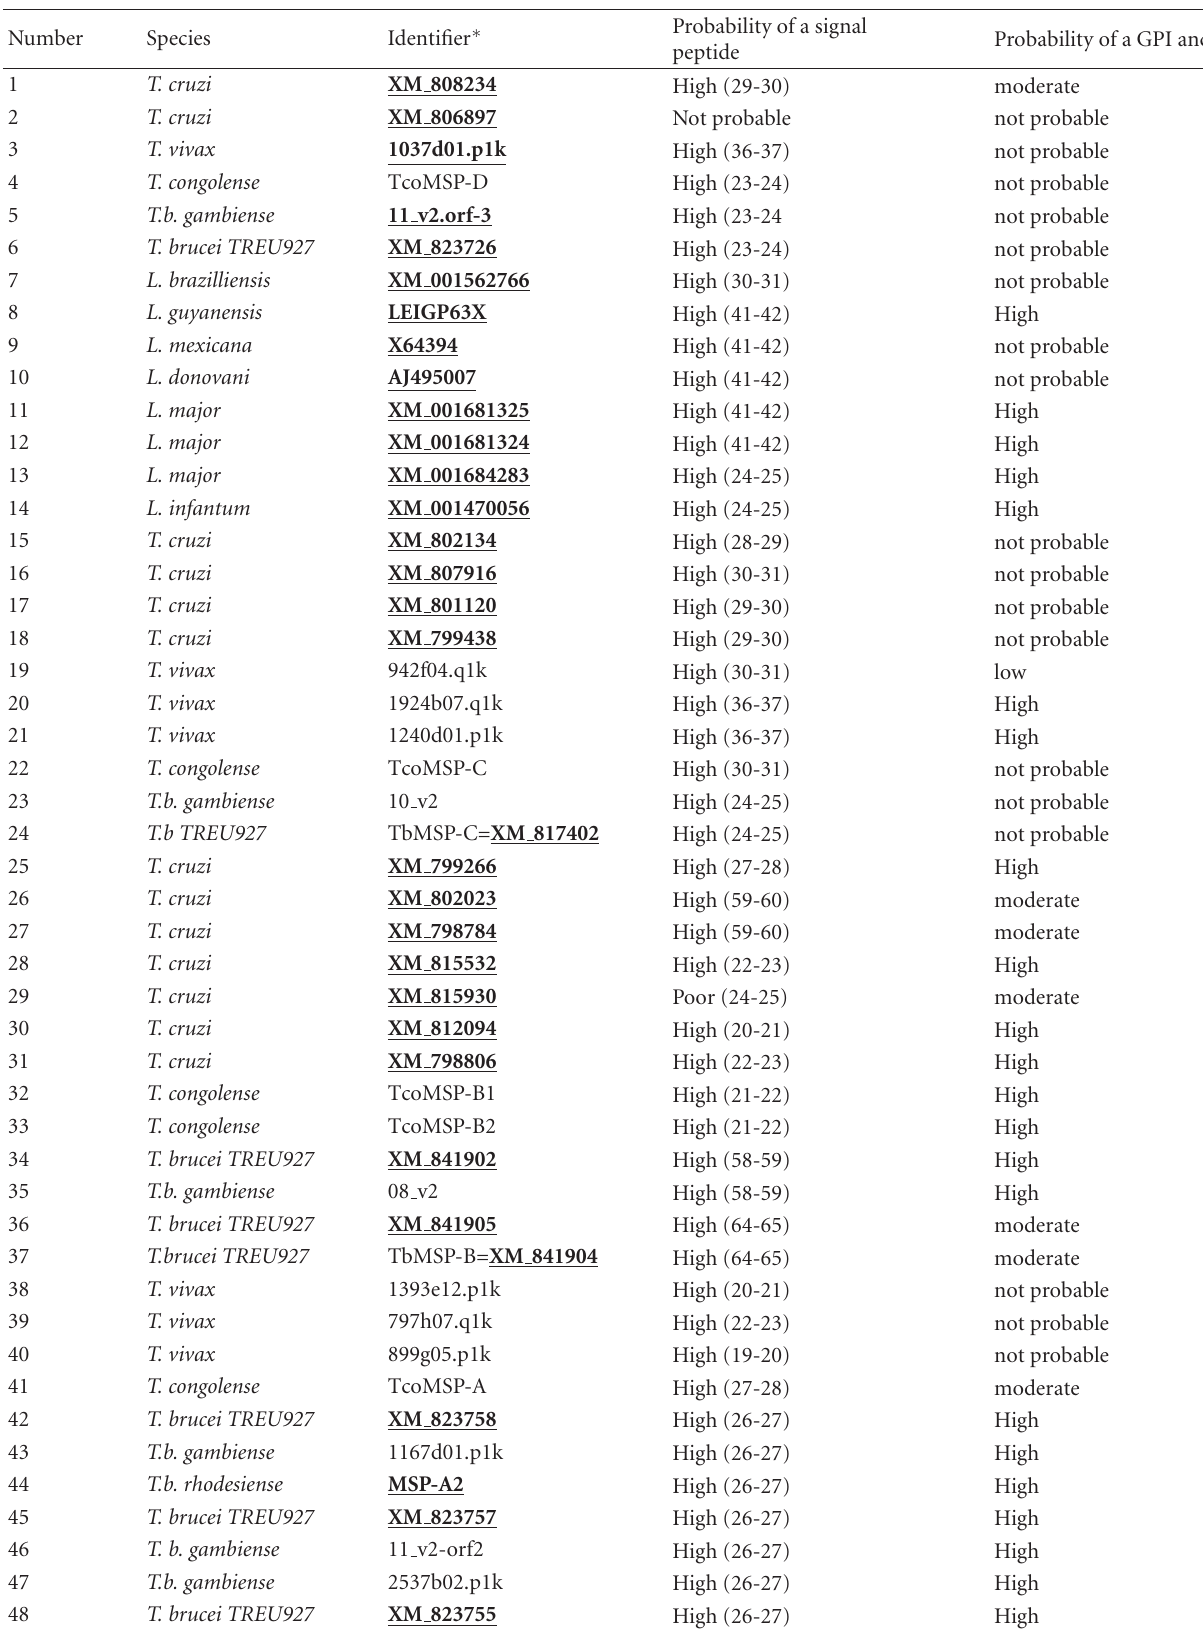
Table 1: Major surface protease